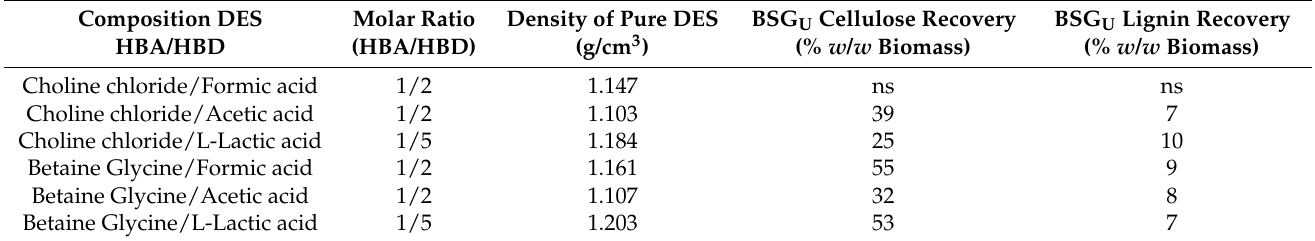
Table 3. List, composition, density (measured at 18 ◦ C) of prepared DESs and data of mass recovery of BSG U Cellulose and BSG U Lignin (ns represents no